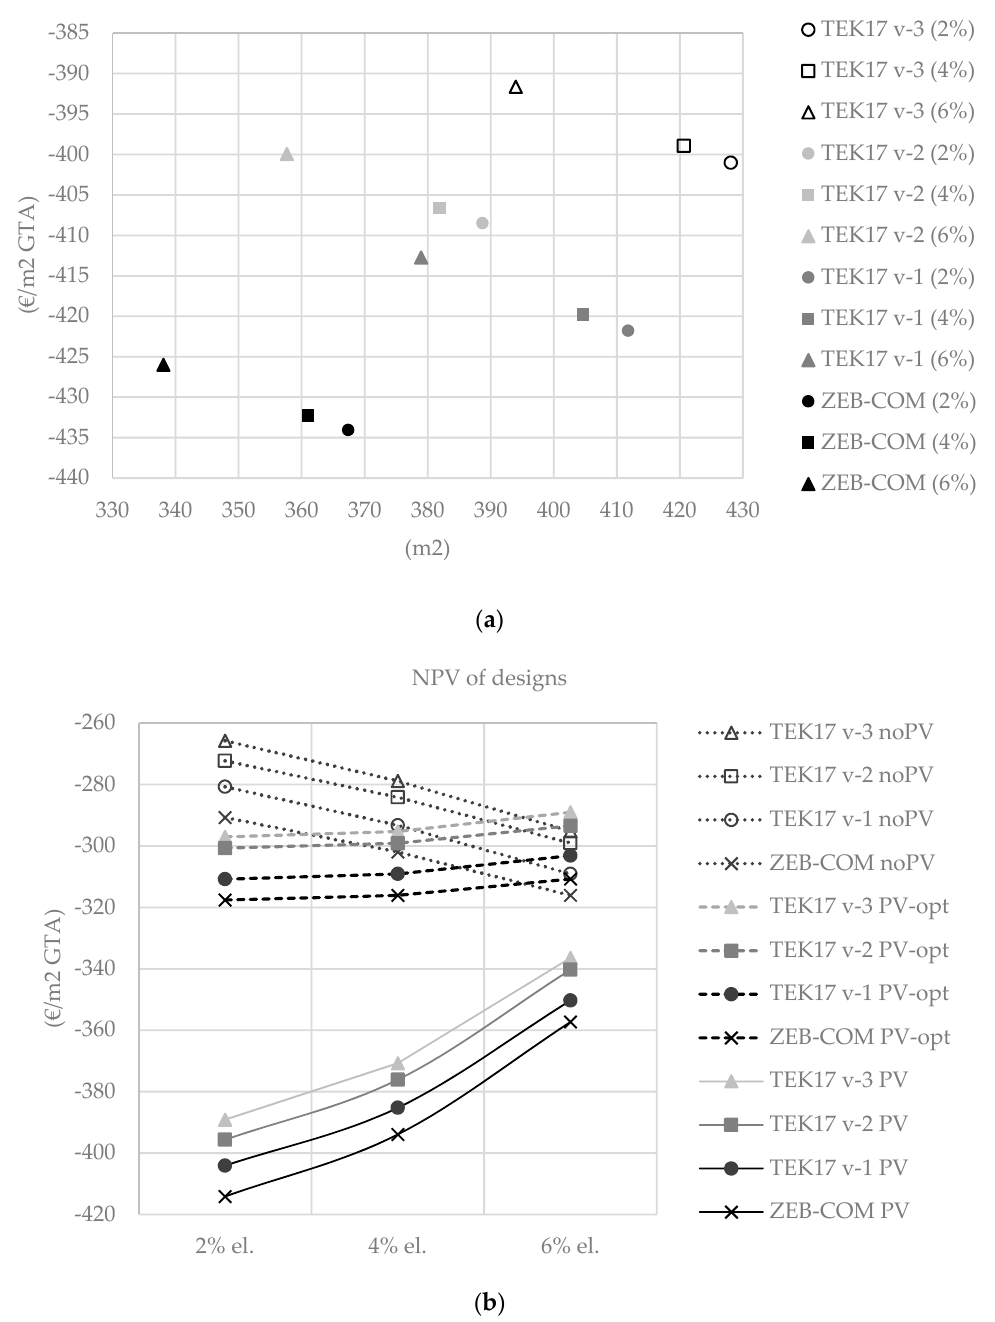
Figure 6. Scatter plot rendering the corresponding initial investments and BIPV areas for the four designs and three electricity price scenarios ( a ). Comparison of the NPVs between all the designs for the three electricity price scenarios ( b ).